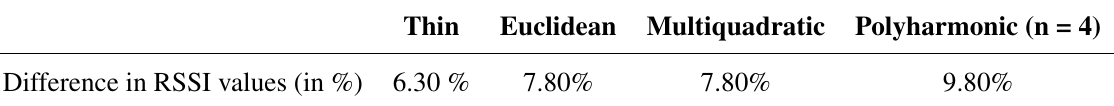
Table 1. Average error between the measured and estimated RSSI (in percentage), when 50% of the reference points are